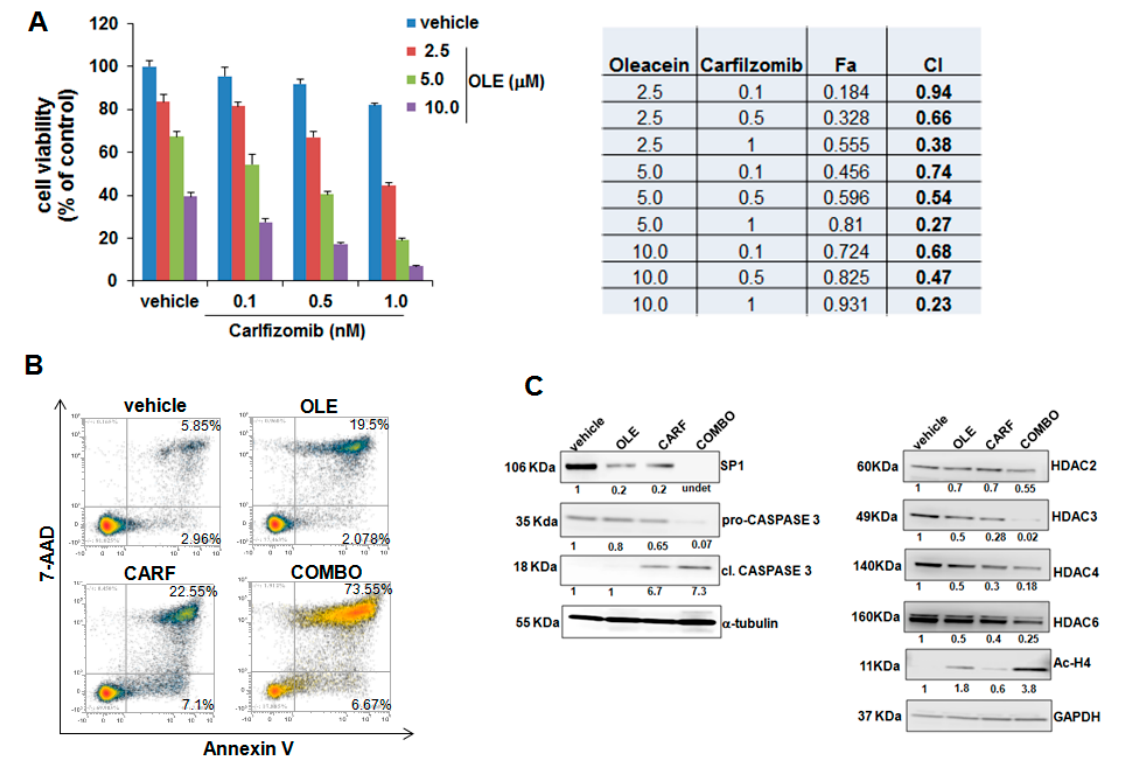
Figure 5. Oleacein enhances the anti-MM activity of carfilzomib. ( A ) CTG assay was performed on NCI-H929 cells treated with oleacein (2.5, 5.0 or 10.0 µM) and carfilzomib (0.1, 0.5 and 1.0 nM). Results are expressed as percentage of the viability of vehicle-treated cells. The right panel reports values of fraction affected (Fa) and combination indexes (CI) in a triplicate experiment, as calculated by the Calcusyn software. ( B ) Annexin V/7-AAD staining of NCI-H929 cells after treatment with vehicle (DMSO), 5.0 µM oleacein and 1.0 nM carfilzomib for 24 hours; a representative FACS experiment is reported. ( C ). WB analysis of pro-Caspase 3, cleaved caspase 3, SP1, HDAC2, HDAC3, HDAC4, HDAC6, and acetylated histone H4 in NCI-H929 cells treated with carfilzomib (1.0 nM), oleacein (5.0 µM) or a combination of the two; α -tubulin or GAPDH were used as loading controls.